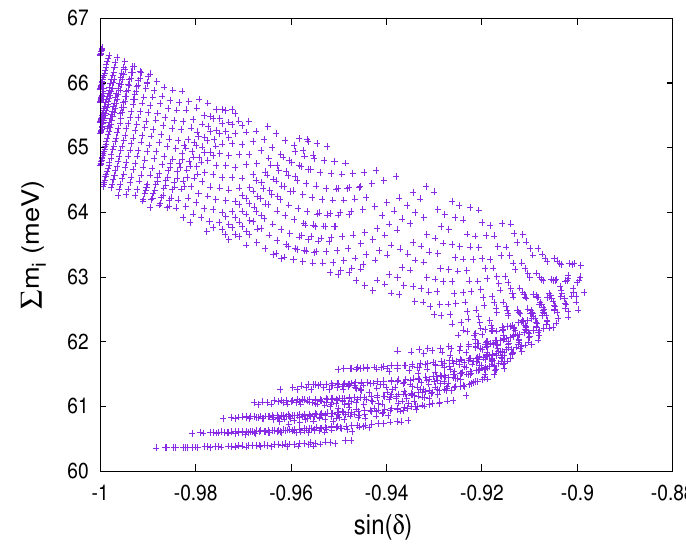
Figure 3 . The predicted ranges of (cid:6) m i and sin (cid:14)